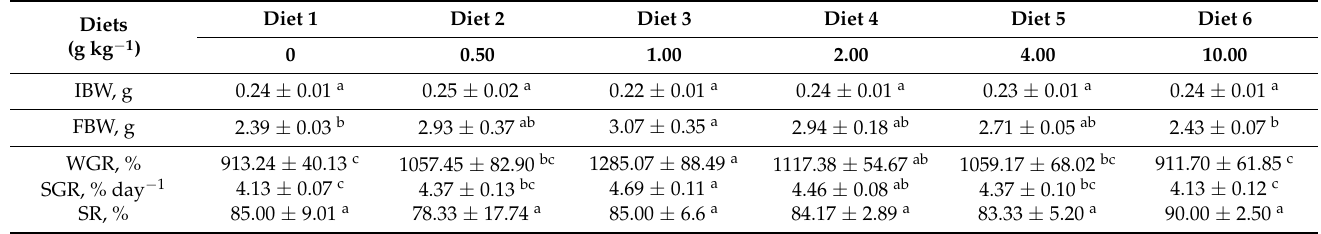
Table 5. Effects of ELE on growth performance of Cherax quadricarinatus